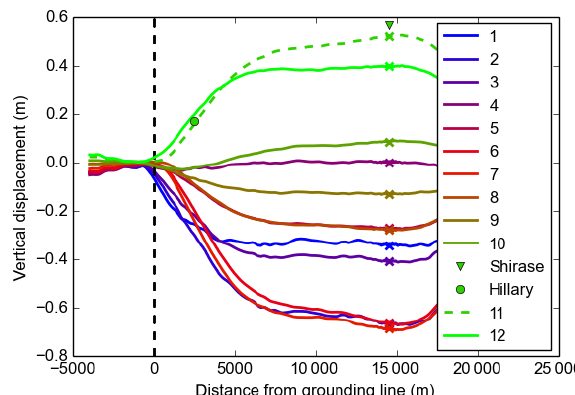
Figure 6. Profiles through the reconstructed maps of vertical dis- placement along the Darwin Glacier’s centerline. The crosses mark the location where the adjusted tide-model output is applied to the α map. The green triangle and dot mark the locations of the two GPS stations Shirase and Hillary and are only used to validate the dashed green profile